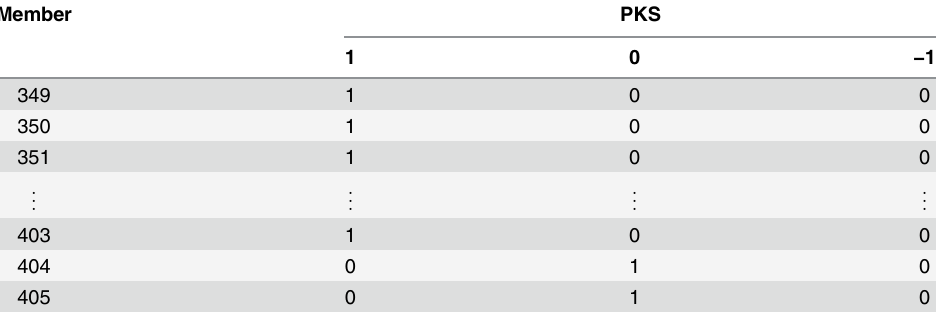
Table 13. A decomposition of Table 10 into multi-tables of Boolean-Valued for PDI-P. Member PDI-P 1 0 − 1 255 0 1 0 256 0 1 0 257 0 1 0 . .. . .. . .. . .. 260 0 1 0 261 0 0 1 262 0 0 1 263 0 0 1 . .. . .. . .. . .. 348 0 0 1